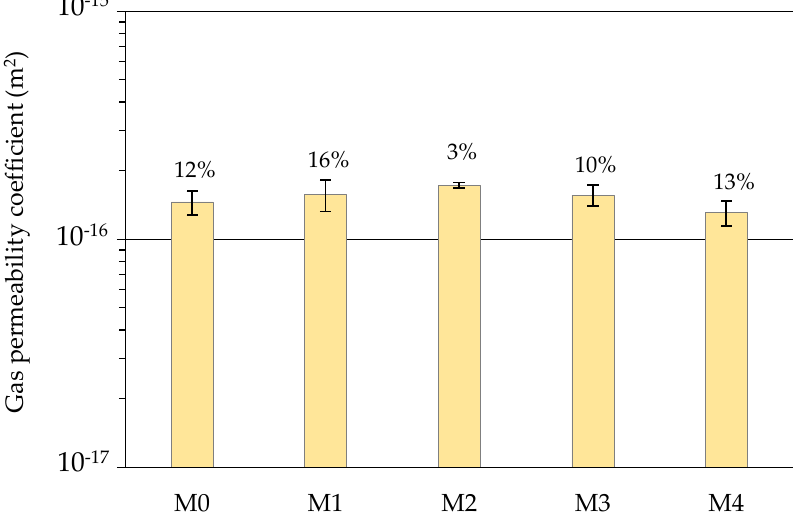
Figure 3. Results of the gas permeability measurements.